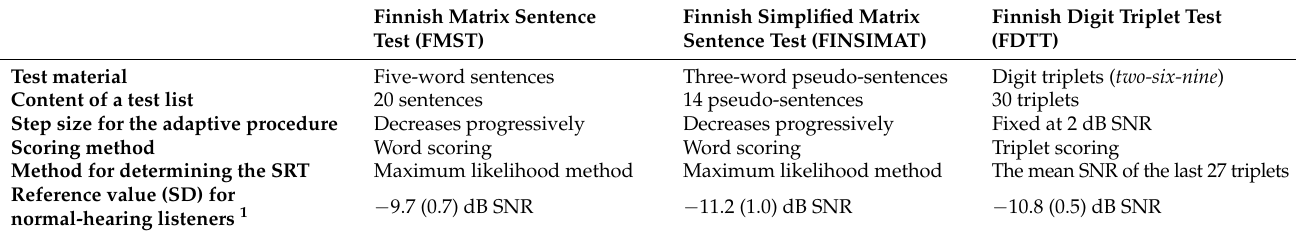
Table 1. The characteristics of the speech intelligibility in noise tests used in the